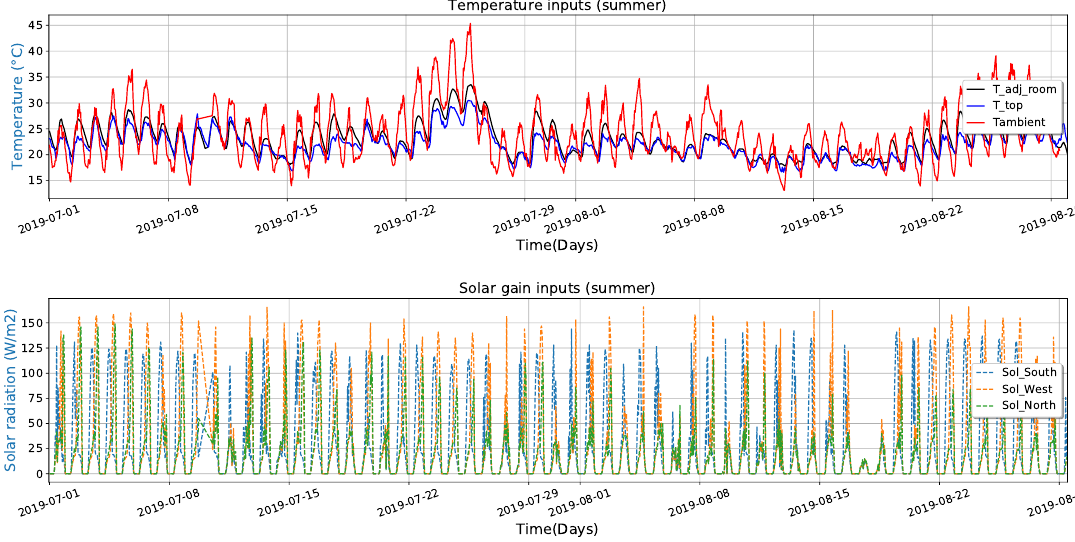
Figure 15. Measured inputs of the model: ambient and adjacent zones temperatures, and solar irradiation